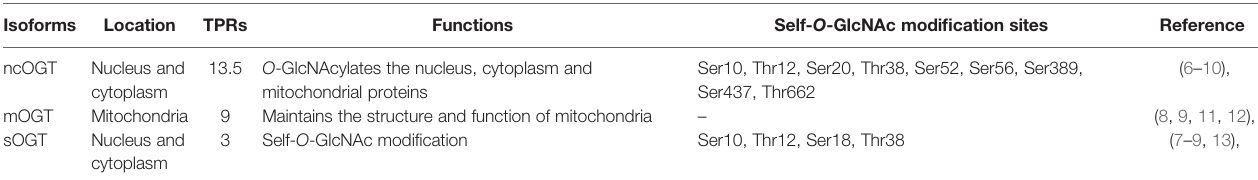
TABLE 1 | Isoforms and functional characteristics of